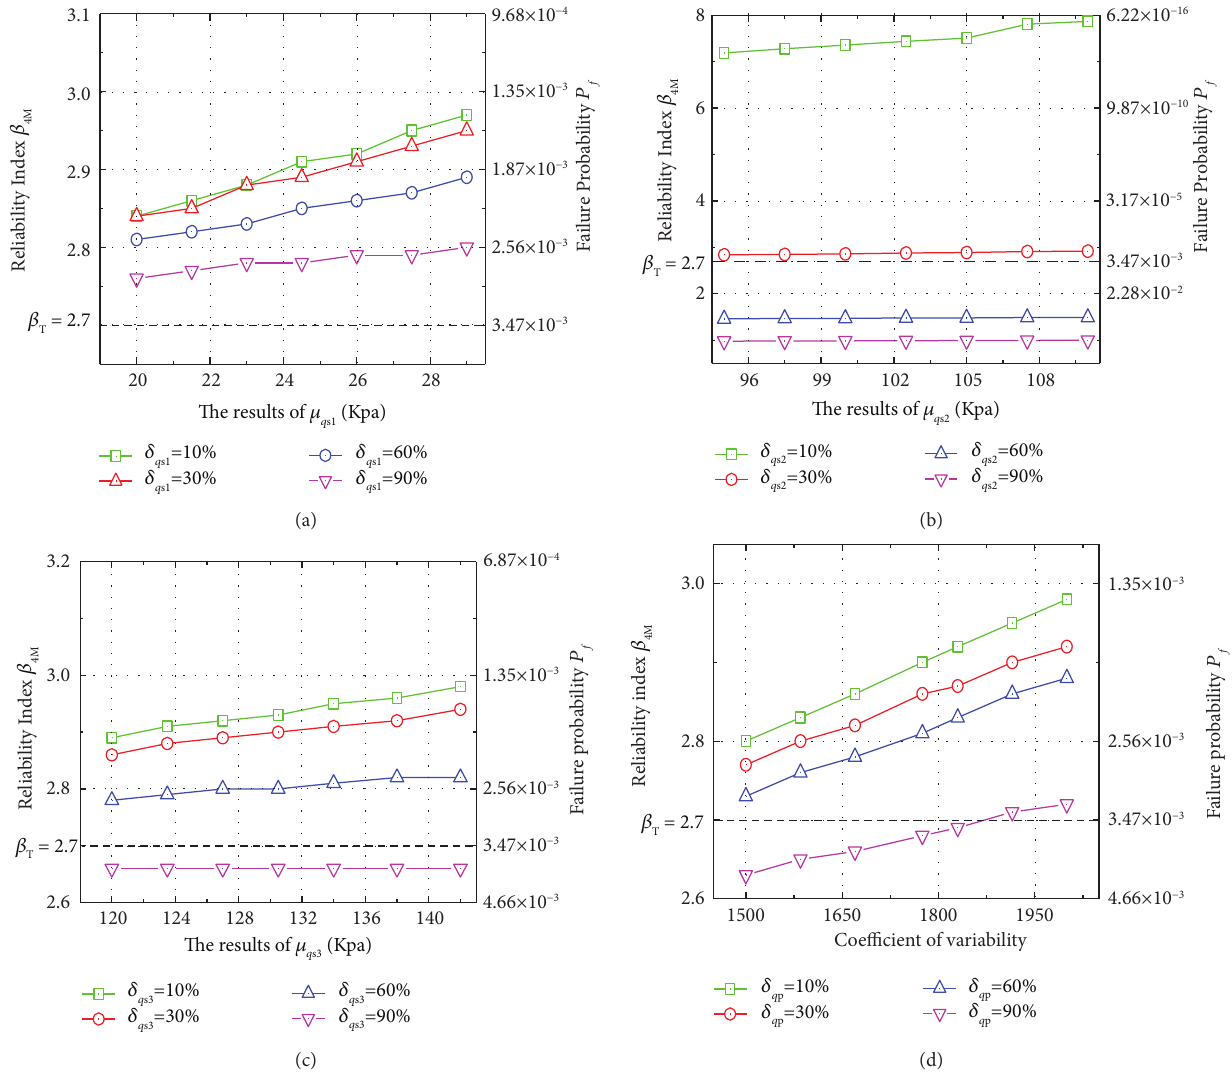
Figure 5: Sensitivity analysis for relative soil layer of no.6 pile foundation: (a) relationship between mean μ (b) relationship between mean μ qs 2 and reliability index β 4 M , (c) relationship between mean μ qs 3 and reliability index β 4 M , and (d) re- lationship between COV and reliability index β 4 M